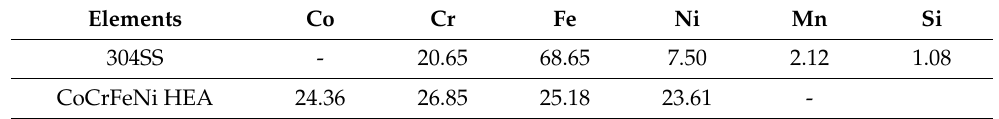
Table 1. Compositions of CoCrFeNi HEA and 304SS by EDS analyses (at.